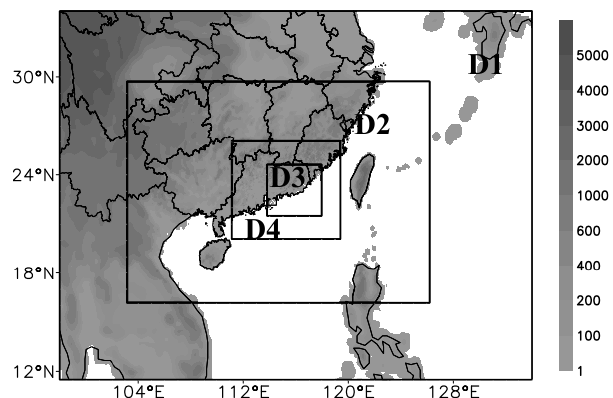
Figure 4. Model domains (D1–D4); the shading indicates the topography.